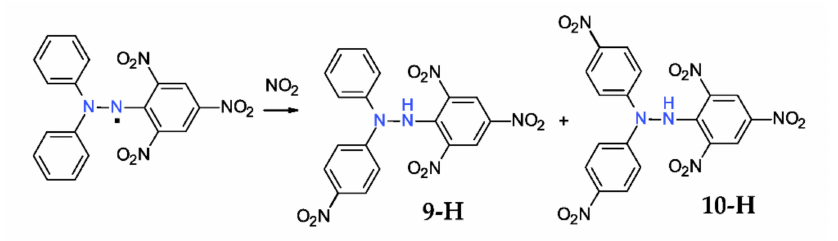
Figure 6. Reaction of DPPH · with nitrogen